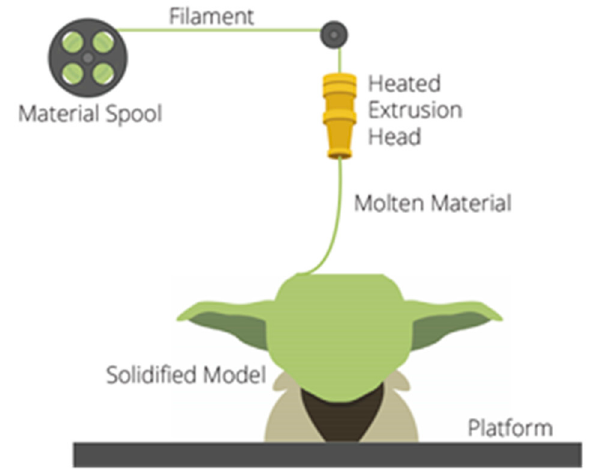
Figure 1. The principle of Fused Deposition Modeling (FDM) technologies [15].